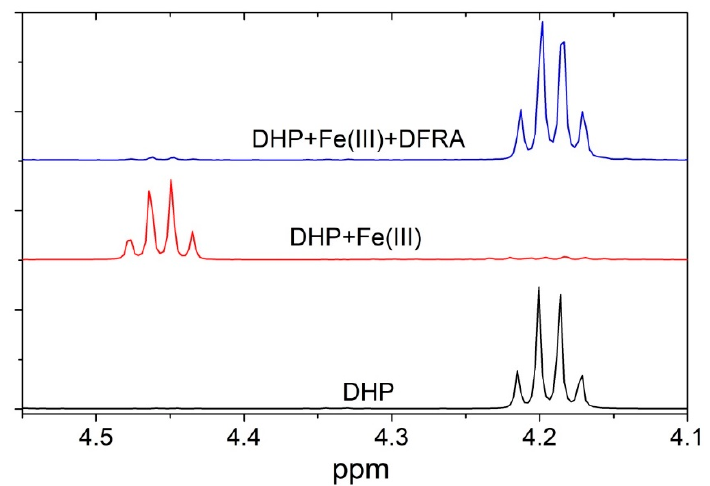
Figure 8. Fragments of 1 H-NMR spectra of the initial DHP (5 mM) and of the reaction mixture with FeCl 3 (0.2 mM) and H 2 O 2 (0.2 mM) after 15 h in the absence and in the presence of DFRA (2 mM) in CD 3 OD solution at 278 K.